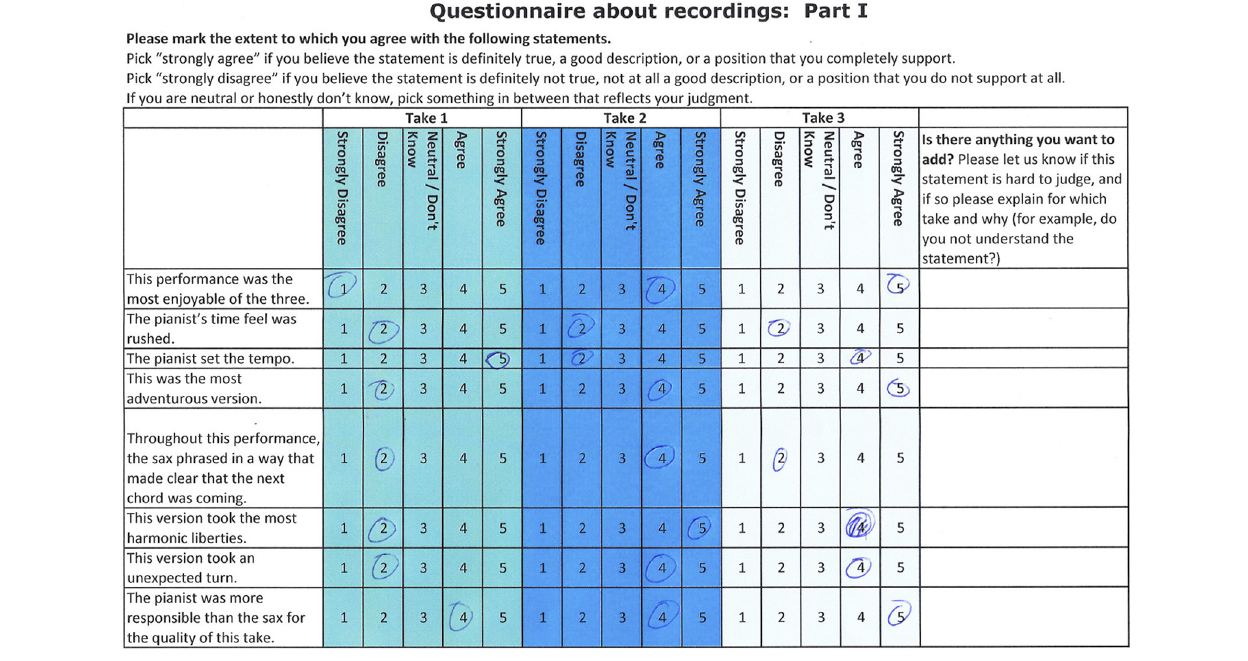
Frontiers in Psychology | Cognitive